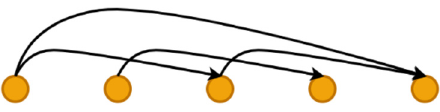
Figure 4. Iterative design of feature pyramid network from level 3 to level 7 (P3-P7). ( a ) FPN pro- poses a top-down pathway to aggregate multiscale features; ( b ) PANet adds an additional bottom- up pathway based on FPN; ( c ) BiFPN adds a bidirectional cross-scale pathway based on PANet; ( d )